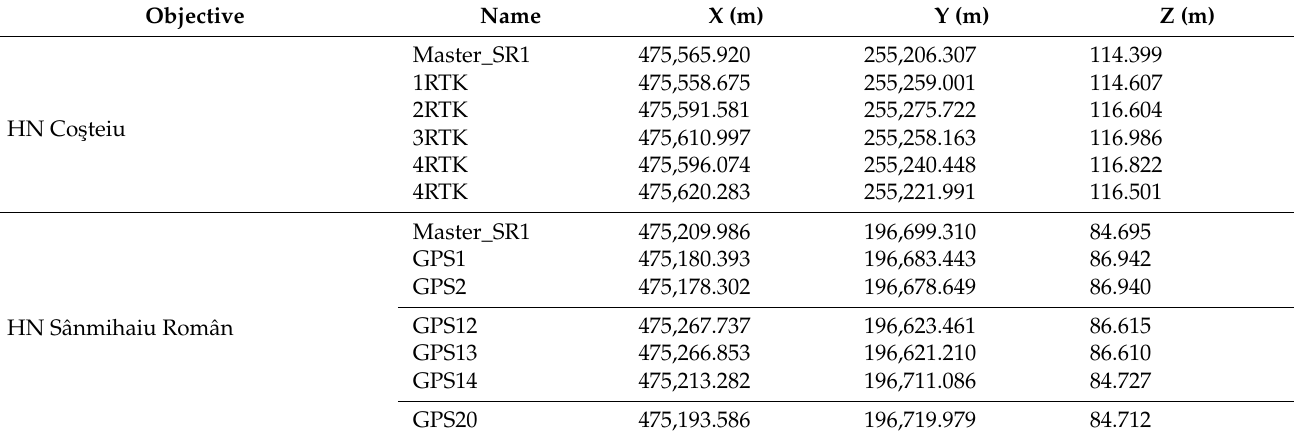
Table 2. GCP ground checkpoints collected in the